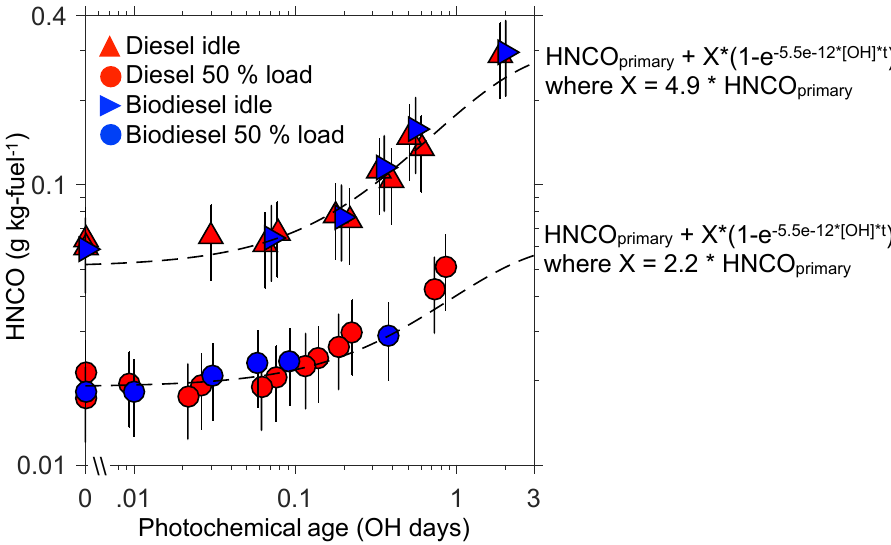
Figure 1. Emission/production factors for HNCO as a function of photochemical age from Link et al. (2016). The fits, which parameterize Figure 1: Summary of emission+production factors for HNCO from Link et al. the emissions of the HNCO precursor and the reaction rate constant with OH, have been performed in this work. The photochemical age is (2016) for different fuel-load combinations. The dashed lines are fits that model calculated assuming an OH concentration of 1 . 5 × 10 6 moleculescm − 3 secondary HNCO production from a proxy precursor (X).